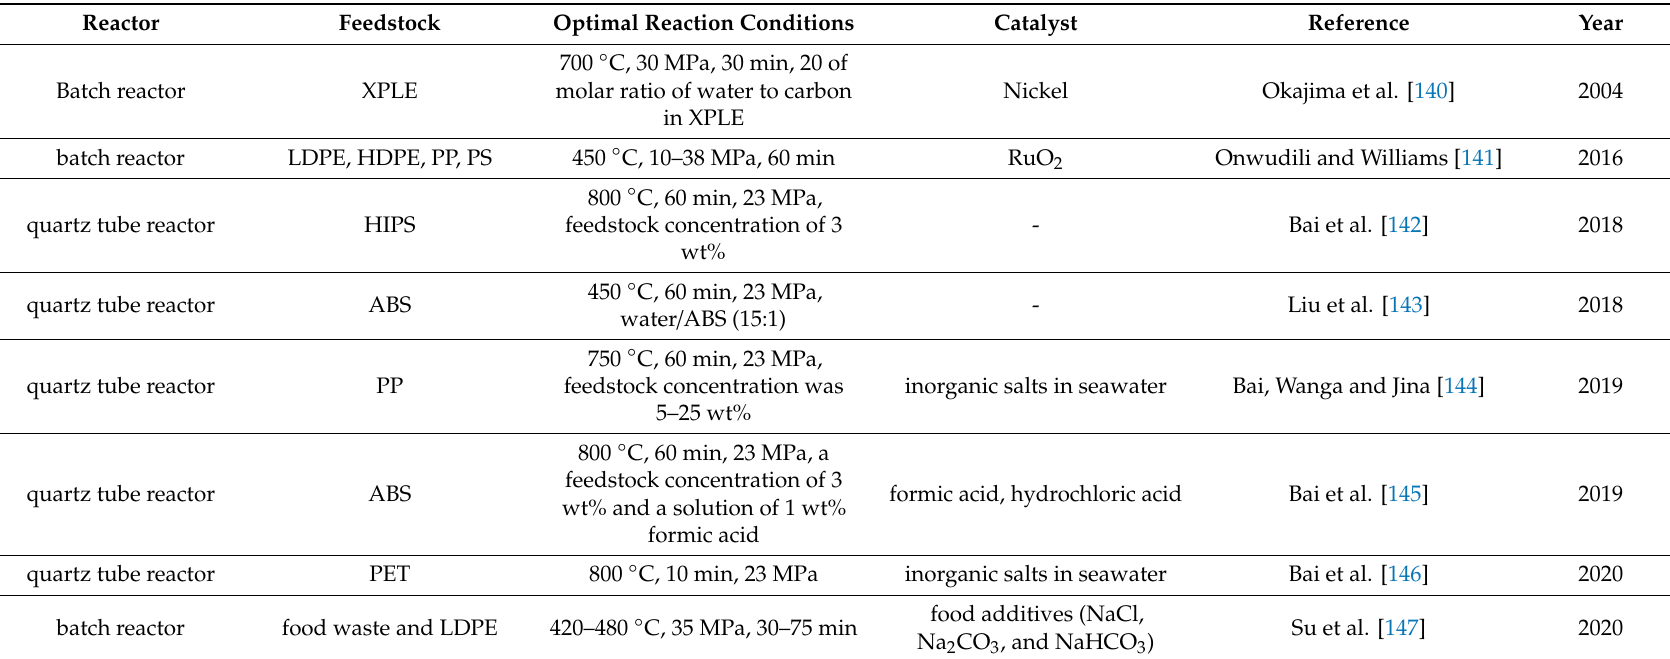
Table 6. Supercritical water gasification summary